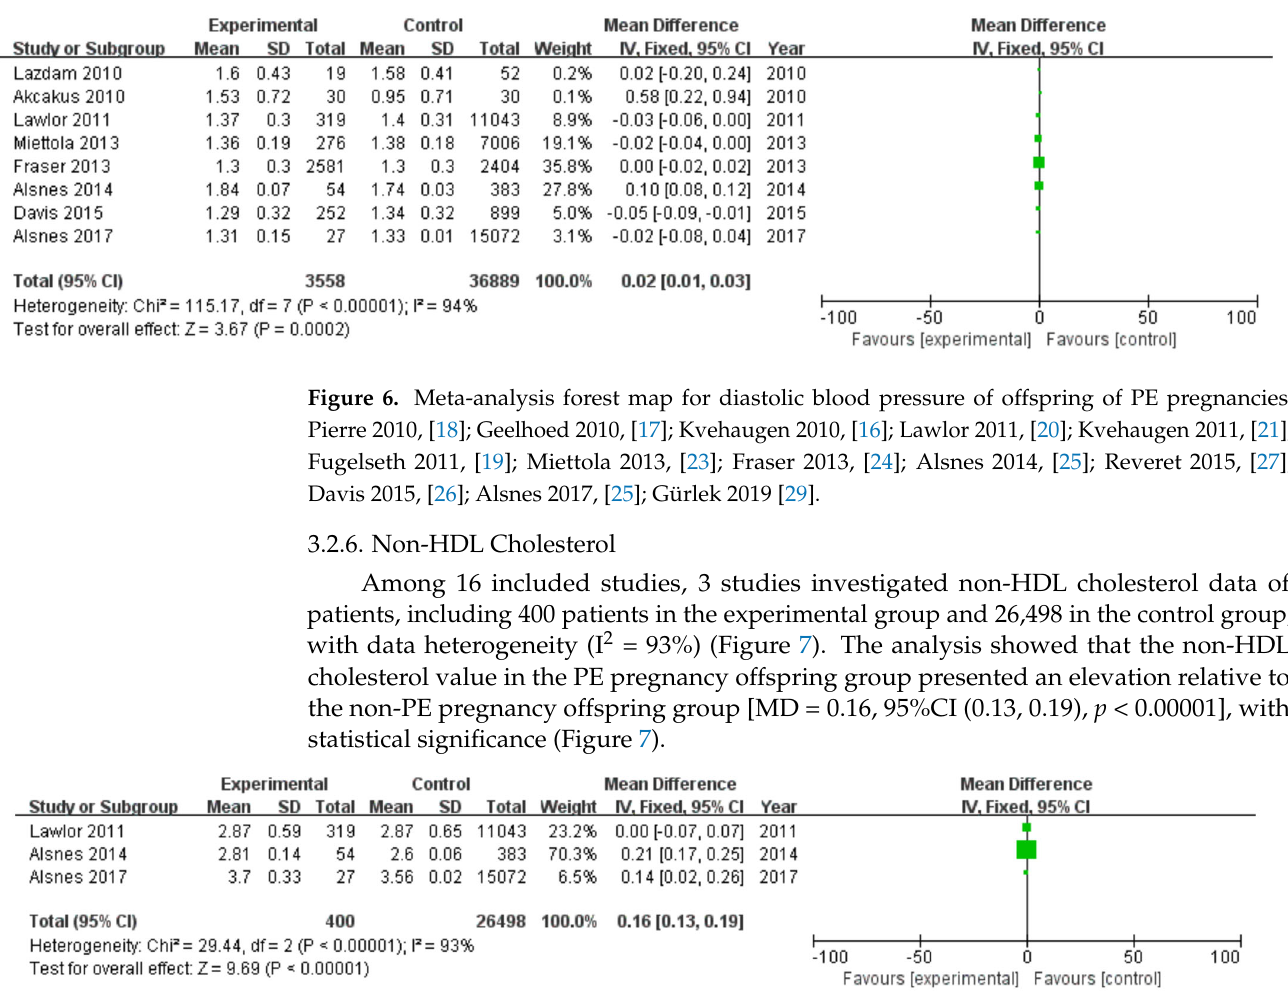
Figure 8. Meta ‐ analysis forest map for triglycerides of offspring of PE pregnancies. Lazdam 2010